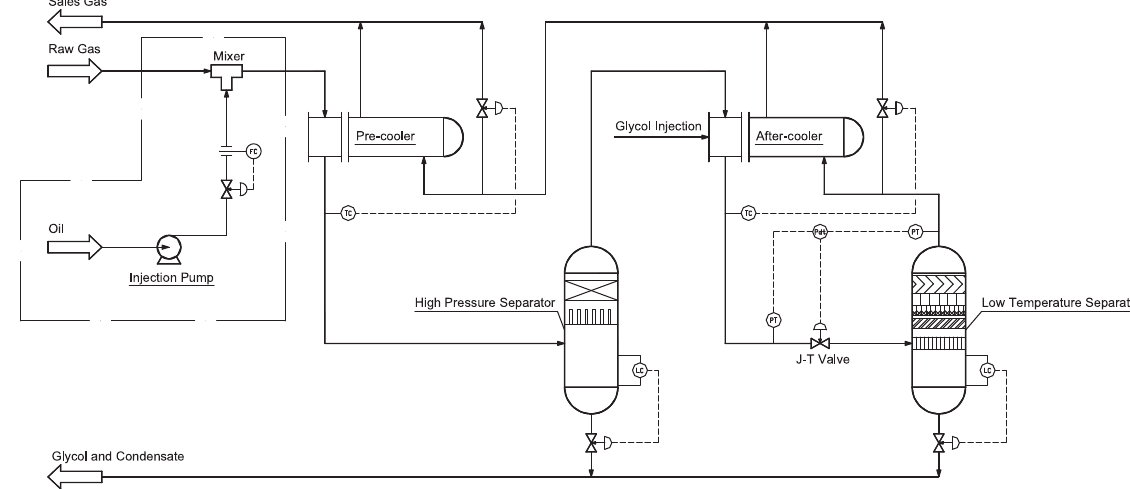
Fig. 5. Oiling Low Temperature Separation (LTS) process fl ow diagram. Pre-cooler: Operation pressure: 12 MPa.g; Operation temperature: inlet temp. 38 (cid:3) C, outlet temp. 20 (cid:3) C; After-cooler: Operation pressure: 11.9 MPa.g; Operation temperature: inlet temp. 20 (cid:3) C, outlet temp. (cid:1) 10 (cid:3) C; High pressure separator: Operation pressure: 12 MPa.g; Operation temperature: 20 (cid:3) C; Low Temperature separator: Operation pressure: 7.9 MPa.g; Operation temperature: (cid:1) 26 (cid:3)